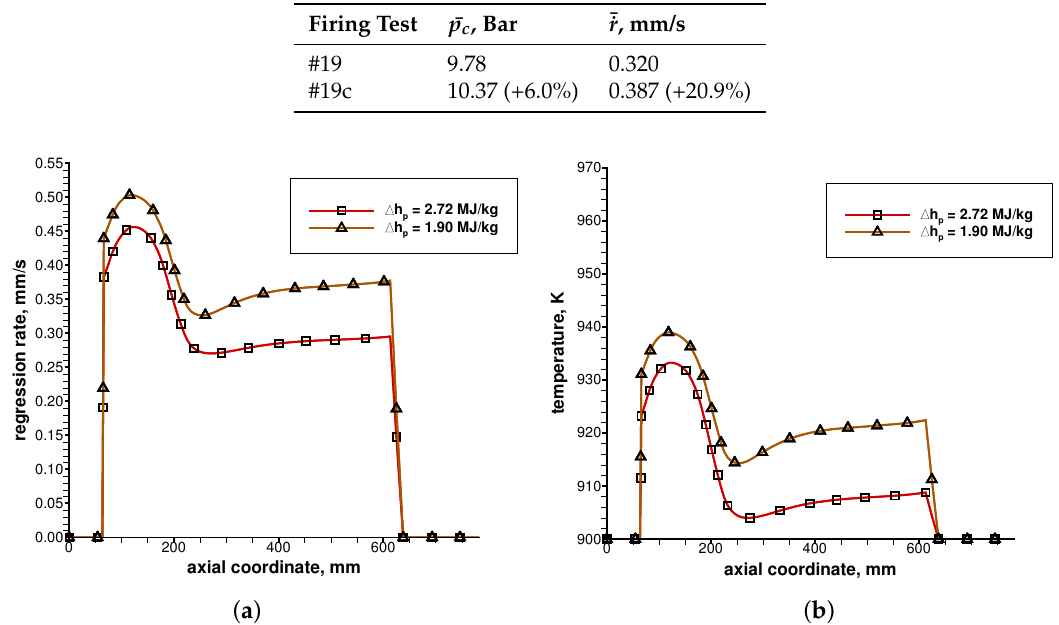
Table 9. Computed average results for Firing Test #19 with the effect of a change in the heat of pyrolysis, Case #19c.